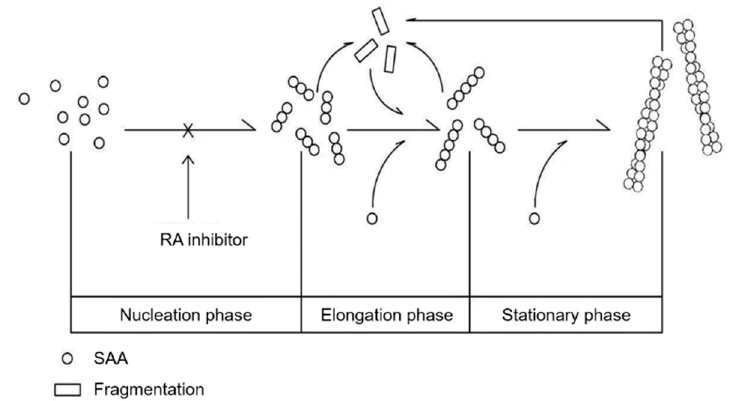
Figure 5. Models showing amyloid fibril formation and inhibition by RA. The mSAA oligomer can assemble further to form higher order oligomers, then rapidly recruit other monomers from the surroundings to assemble amyloid fibrils. RA can inhibit an oligomer from forming a higher order oligomer or / and amyloid fibrils in nucleation and elongation phases, but cannot degrade the formed fibrils.